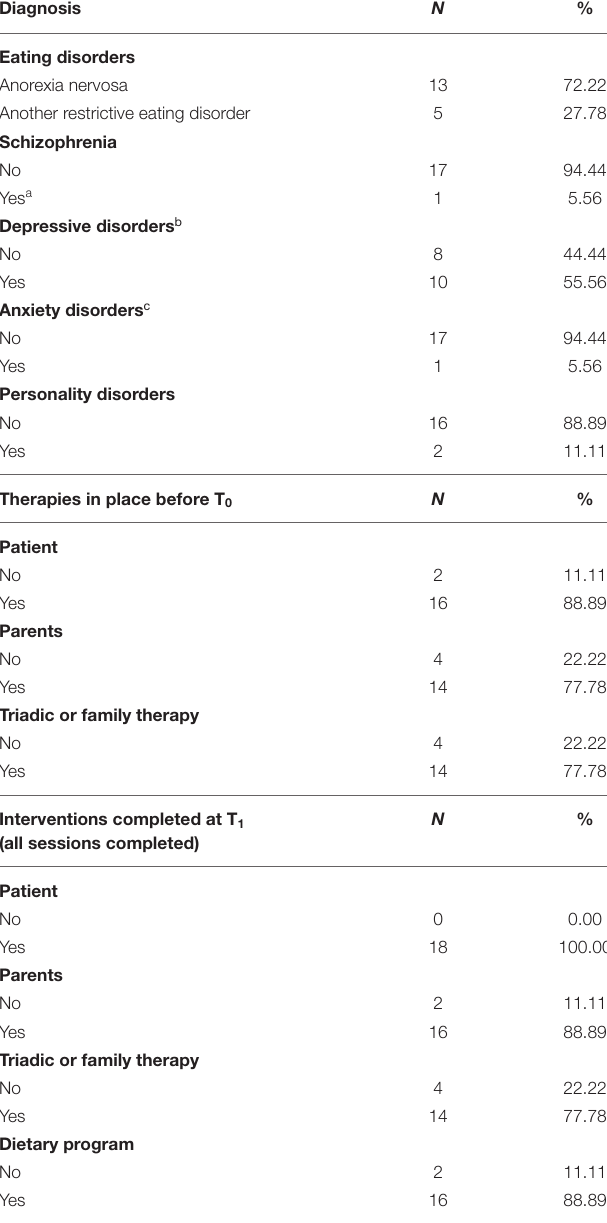
TABLE 1 | Descriptive statistics: patients’ baseline diagnoses and therapies both before and during the multidisciplinary treatment program. Diagnosis N % Eating